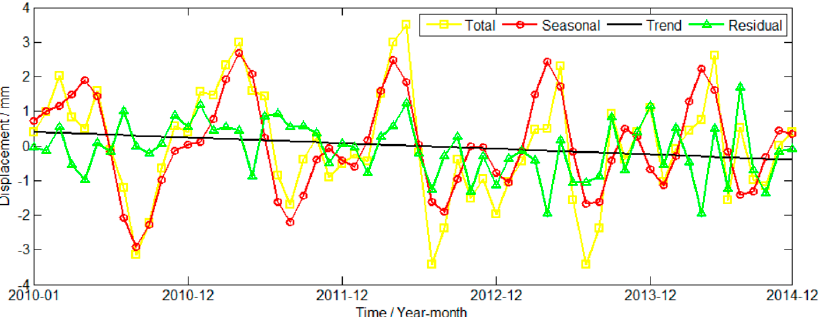
Figure 4. Vertical deformation series and decomposition signals of terrestrial water load in SGN from 2010 to 2014.